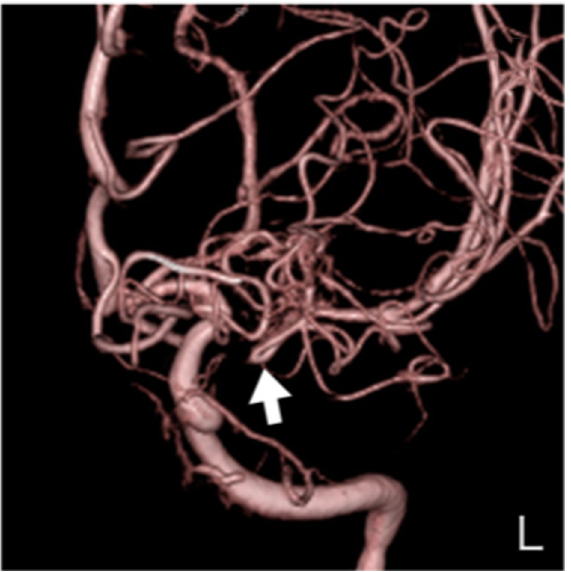
Figure 6. Anterior posterior view of three-dimensional digital subtraction left internal carotid angiographical findings in patient 6 indicating left twig-like middle cerebral artery (white arrow). The moyamoya vessels were not present.